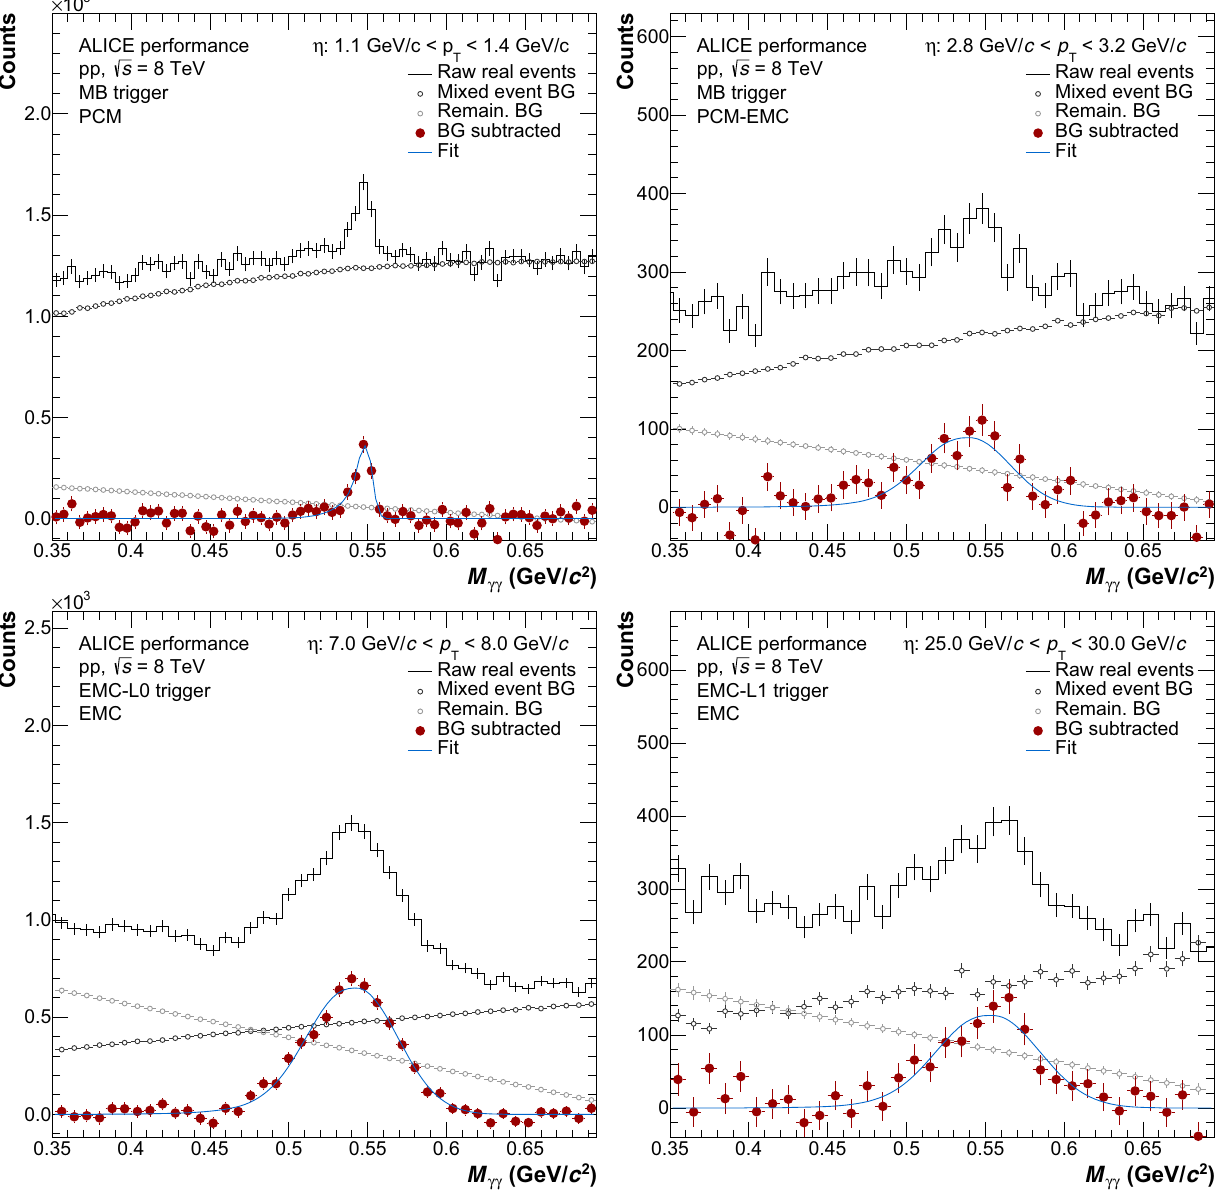
Fig. 3 Example invariant mass spectra in selected p have been subtracted from raw real events to obtain the signal displayed T slices in PCM with red data points. The blue curves represent fits to the background- (top left), PCM-EMCal (top right) and EMCal (bottom plots) in the η mass region. The black histograms show raw invariant mass dis- subtracted invariant mass spectra. Additional examples of invariant mass distributions for the different methods are given in Ref. tributions before any background subtraction. The grey points show mixed-event and residual correlated background contributions, which